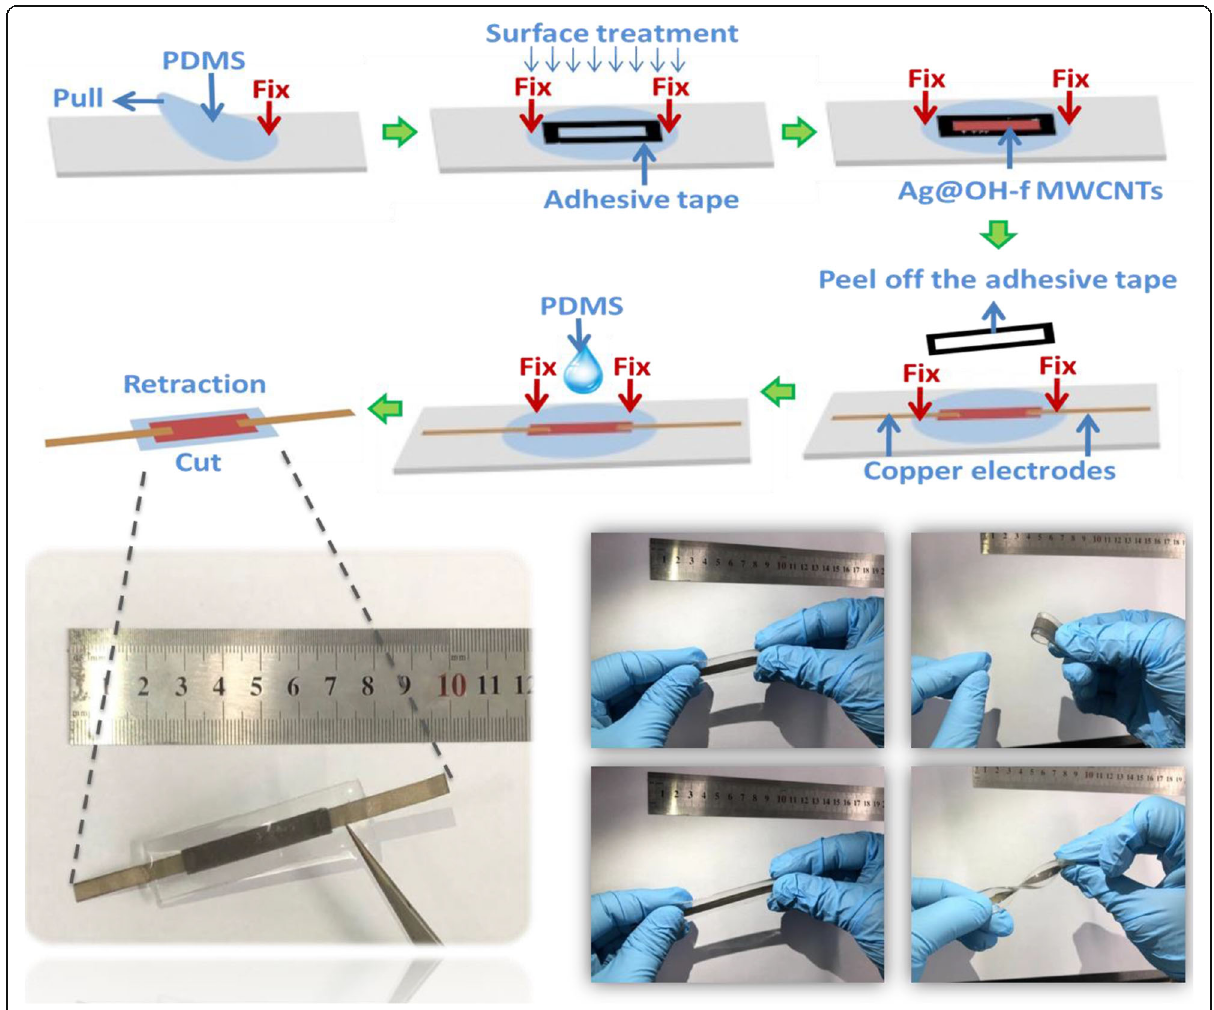
Fig. 1 Fabrication process flowchart of the